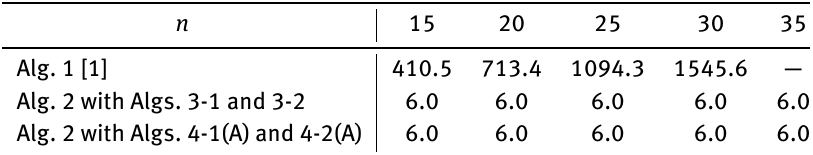
Table 1: Numbers of iterations of Algorithms 1 and 2 for high symmetry T in (1) . T is generated from a = (100, 100, 100) , b = (1, 1, 1) , and c = 1 in (17) – (19) , and the size of T is n 3 × n 3 . The symbol “—” means that the algorithm did not converge to the minimum singular values of T .